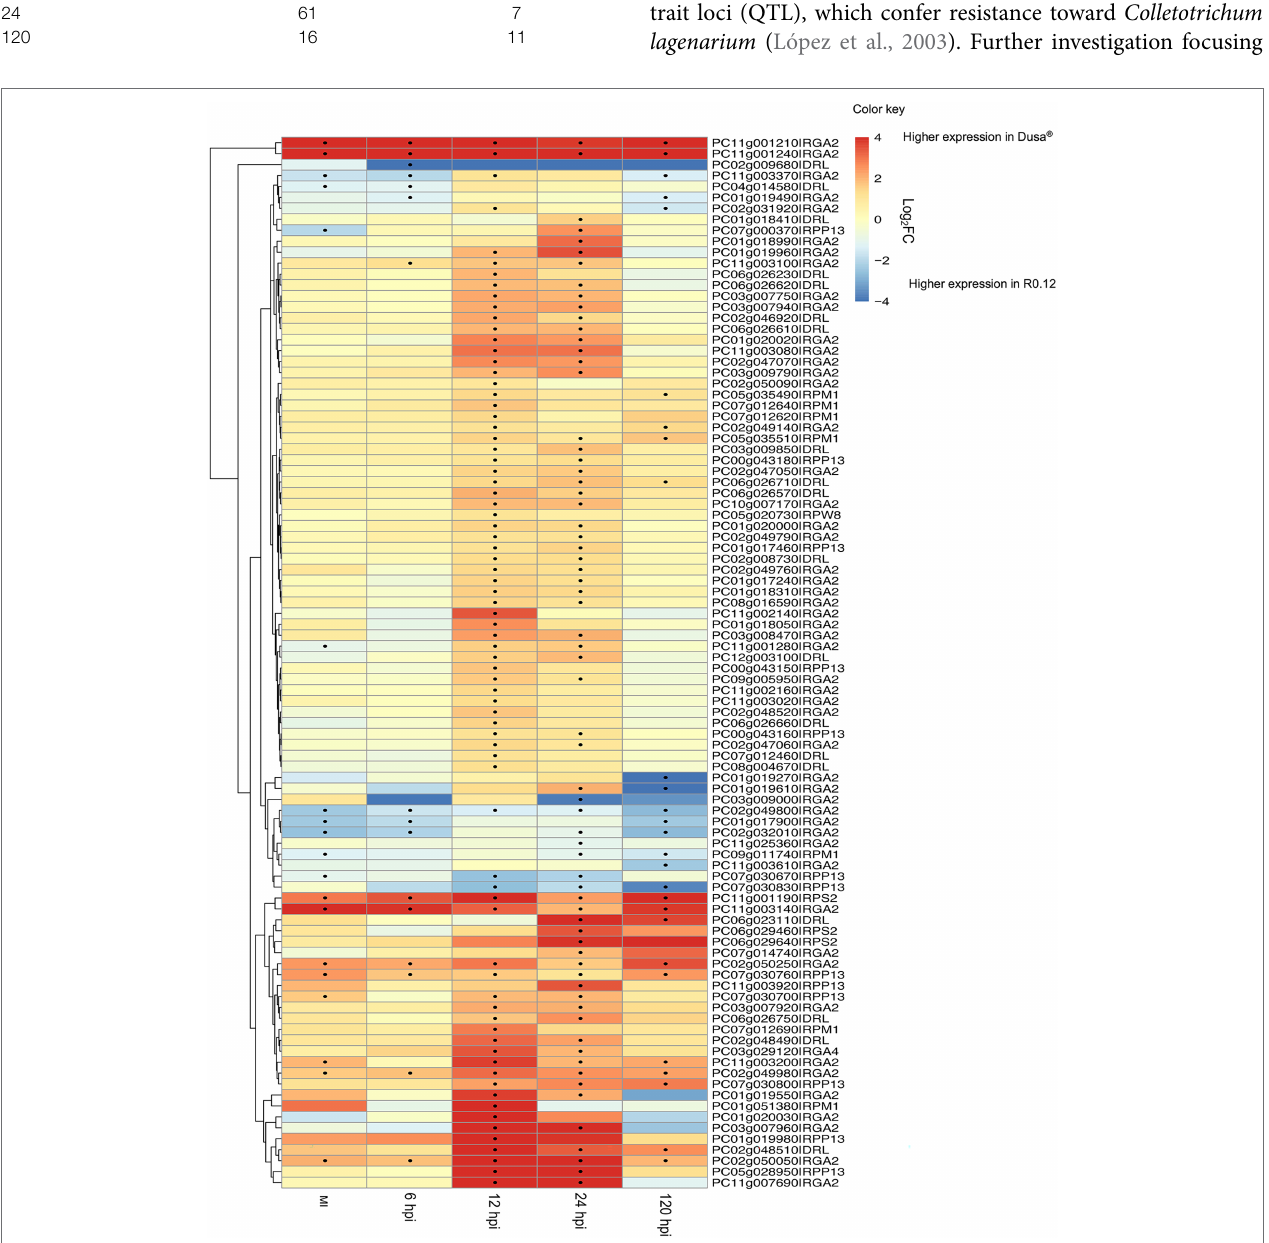
FIGURE 5 | Heatmap and dendrogram showing PaNLR expression levels in a partially resistant avocado rootstock (Dusa®) mock-inoculated (MI) and following Phytophthora cinnamomi inoculation (hpi, hours post-inoculation) using a susceptible rootstock (R0.12) as the reference. A positive Log 2 FC indicates higher expression in the partially resistant rootstock, while a negative Log 2 FC indicates higher expression in the susceptible rootstock. Dots indicate a significant difference ( p ≤ 0.05 and |Log 2 FC| ≥ 1) in expression between the two rootstocks.